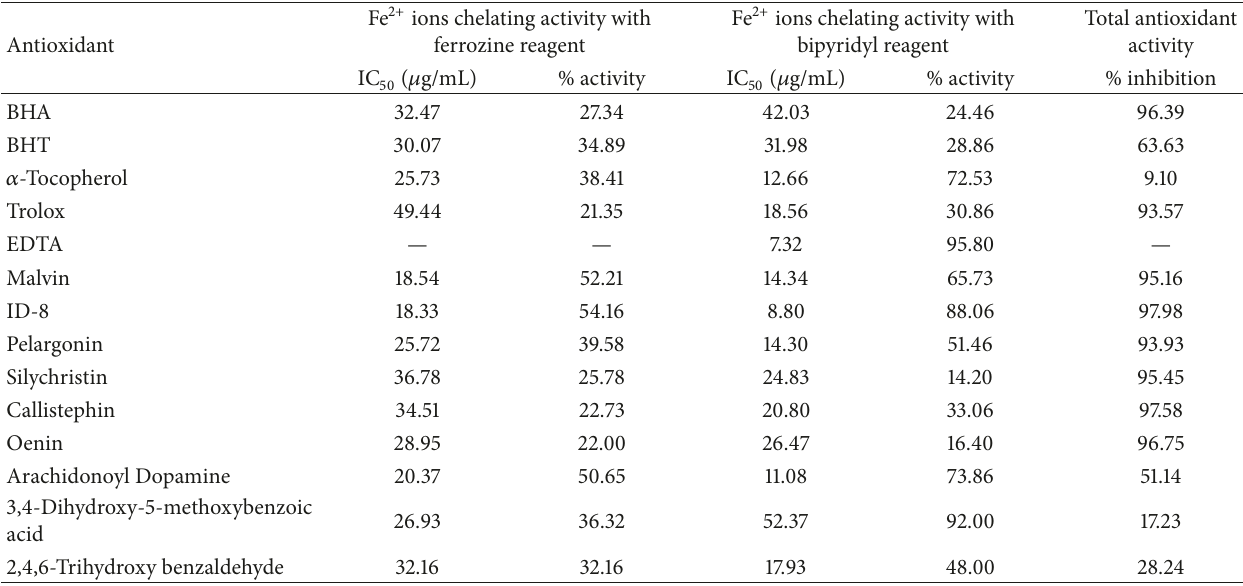
Table 1: The comparison of lipid peroxidation inhibition percentages and ferrous ion (Fe 2+ ) chelating activities of reference antioxidants and some phenolic and flavonoid compounds (10 𝜇 g/mL for chelating activity and 20 𝜇 g/mL for lipid peroxidation inhibition).